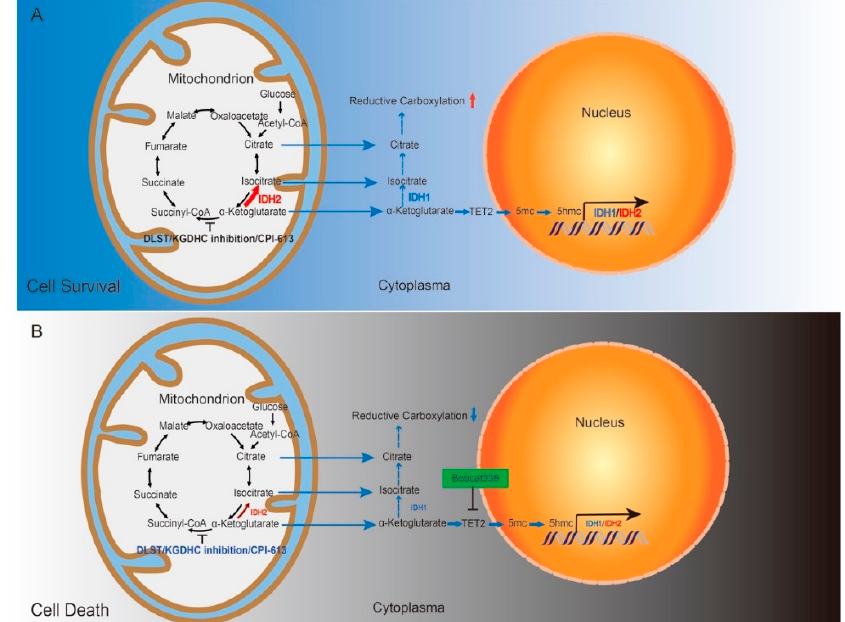
Figure 7. Schematic drawing of our working model. ( A ) Disrupting the TCA cycle alone leads to enhanced reductive carboxylation and T-ALL cell survival through TET-mediated demethylation and upregulation of IDH1 and IDH2. ( B ) Combined inhibition of the TCA cycle and TET-mediated demethylation kills T-ALL cells by decreasing the production of IDH1 and IDH2 and subsequently dampening reductive